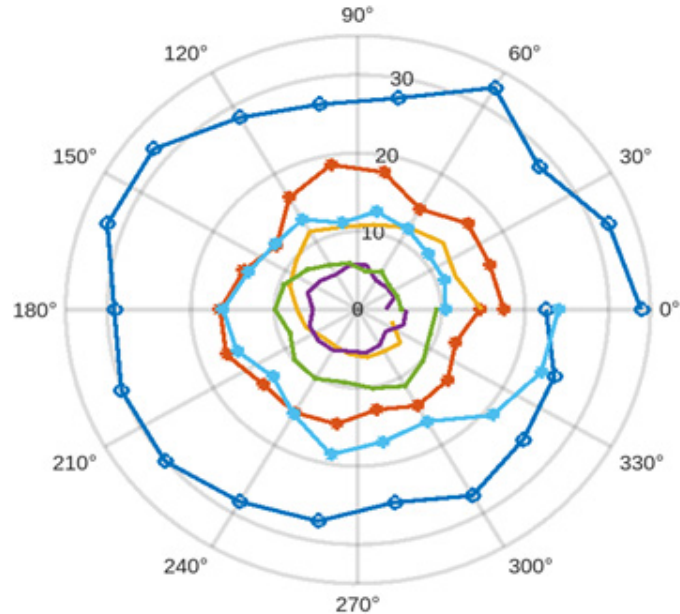
Figure 17. Dipole Antenna RSSI.